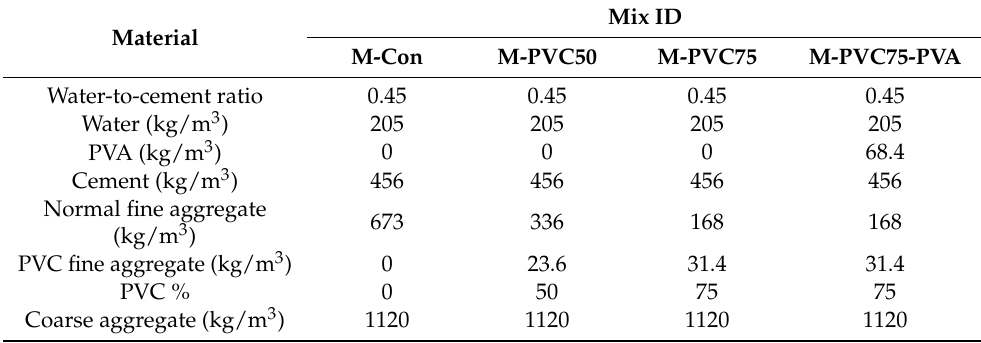
Table 4. Mix design of the normal